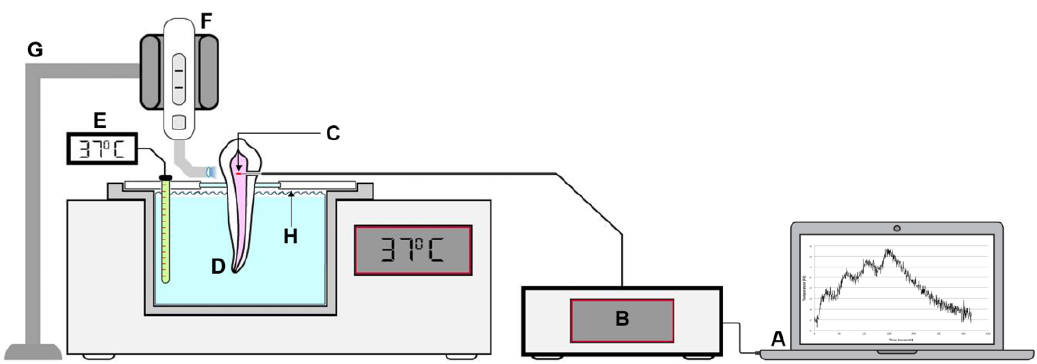
Figure 3. Schematic representation of the setup for PT measurement: A —Laptop; B —optical sensing interrogator; C —FBG sensor; D —thermostatic water bath; E —digital thermometer for double monitoring; F —LED LCU; G —LED LCU holder; H —individualized tooth